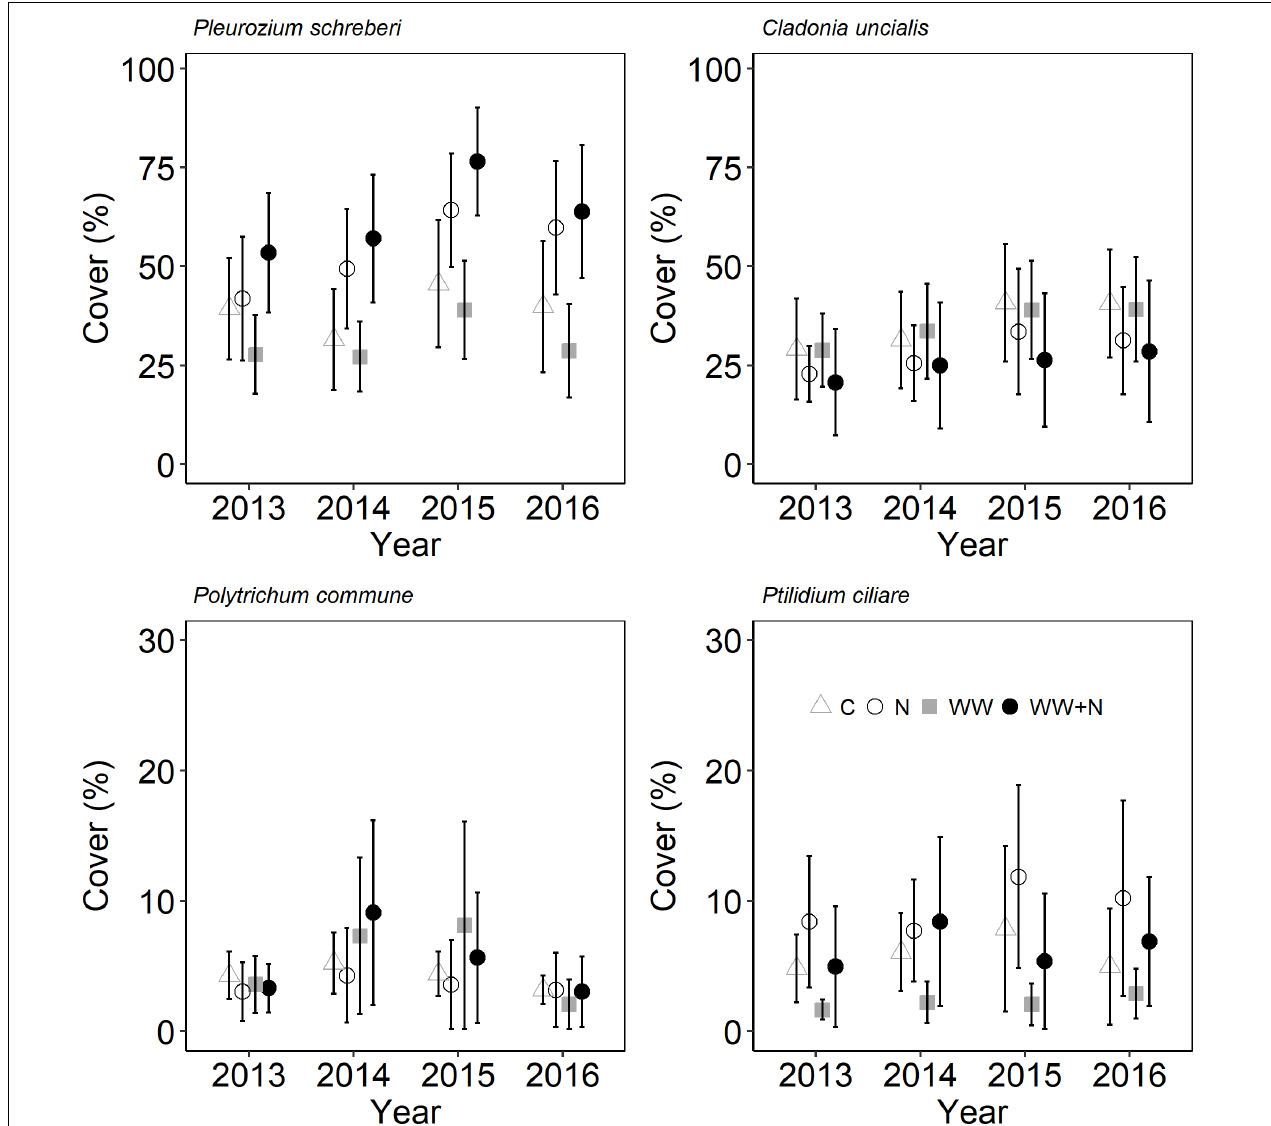
FIGURE 4 | Species-specific cryptogam cover following extreme WW and nitrogen (N) additions in sub-arctic Norway. Data points are mean of n = 6 plots with SE as error